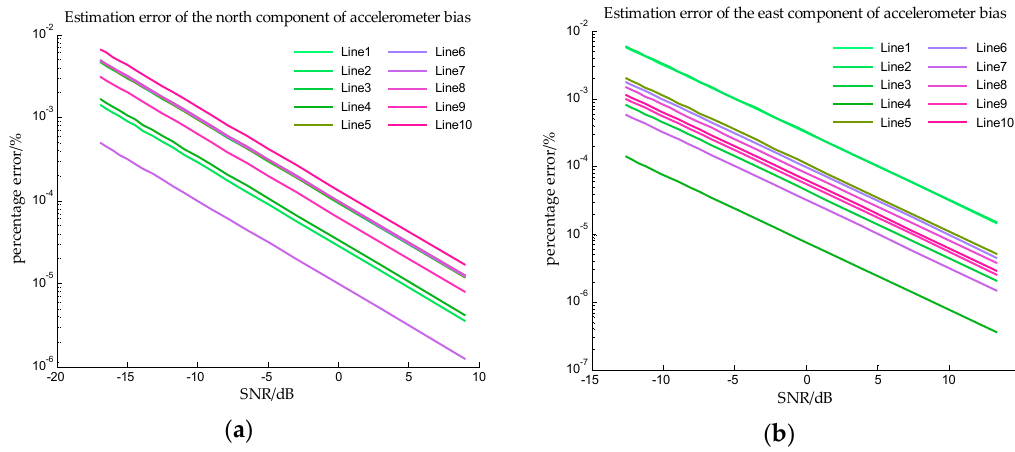
Figure 12. The estimation error of accelerometer bias in simulation I. ( a ) is the estimation error of the north component of the accelerometer bias, and ( b ) is the estimation error of the east component of the accelerometer bias.